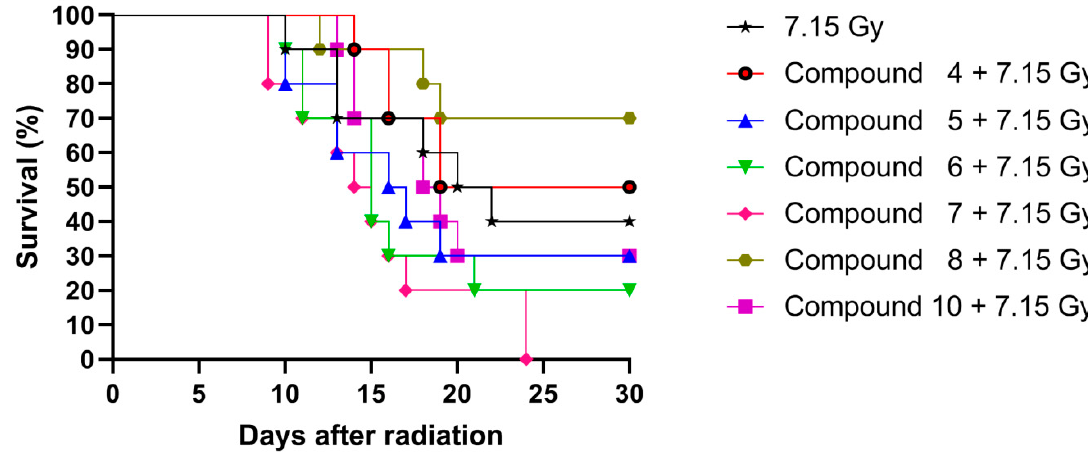
Figure 3. Kaplan–Meier survival curves of irradiated mice pre-treated intraperitoneally (i.p.) with saline buffer (7.15 Gy) and with compounds 4 , 5 , 6 , 7 , 8 , and 10 . Each group (n = 10) was observed until termination of the experiment (30 days after irradiation).